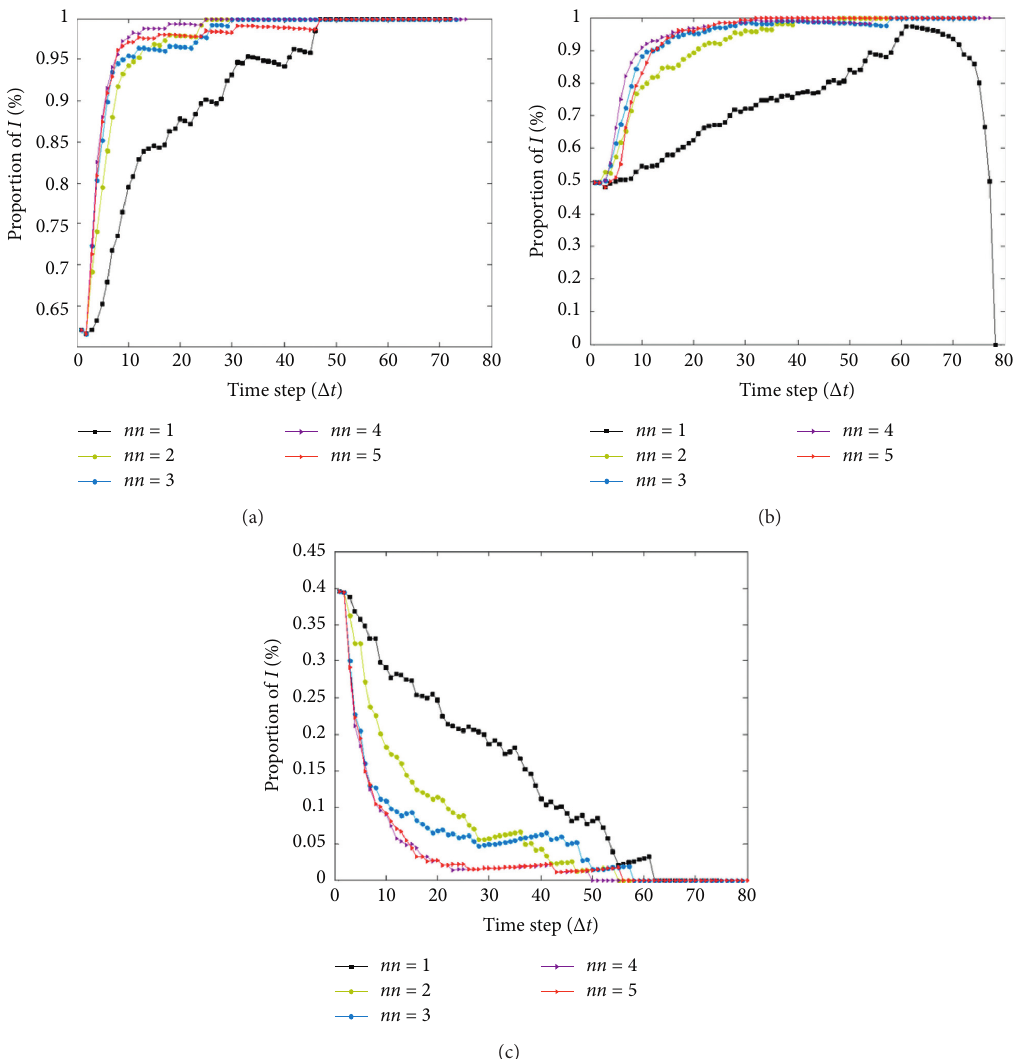
� 0 . 4. (b) λ � 0 . 5. emotion emotion